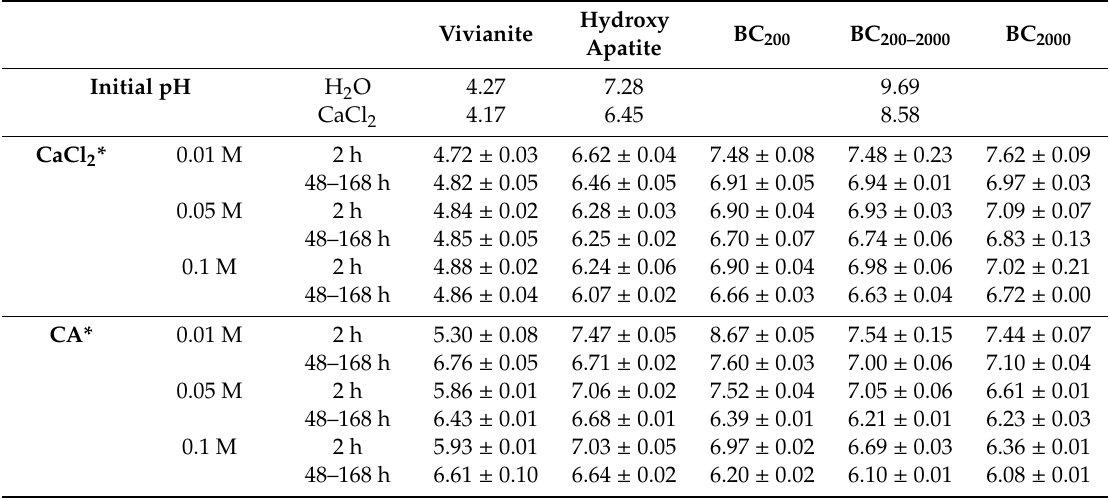
Table 6. pH value of the raw material and in the reaction solution after 2 h and 48–168 h reaction time.